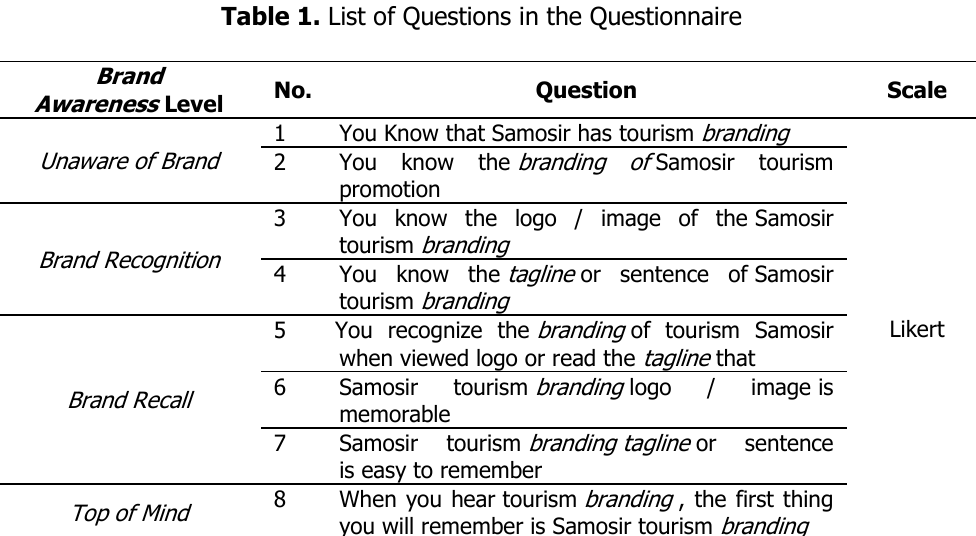
Table 1. List of Questions in the Questionnaire